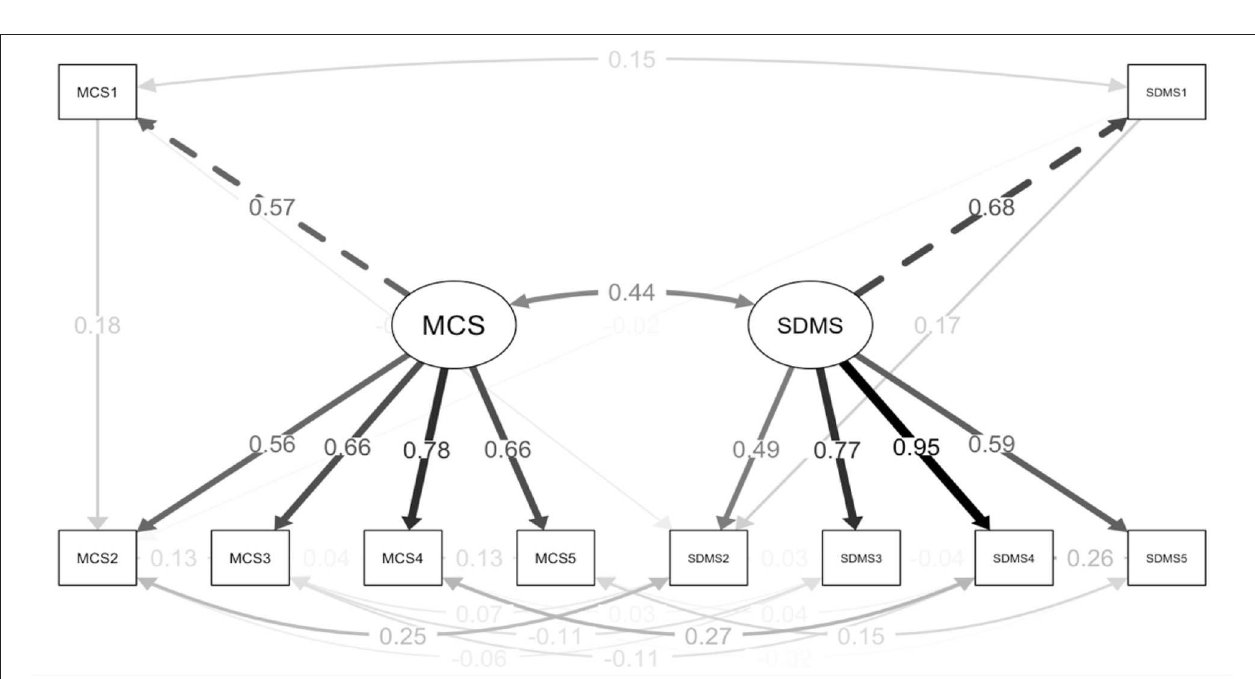
FIGURE 3 | EFA model with standardized estimates. Magnitudes of the estimates are reflected by the intensity of the black color.